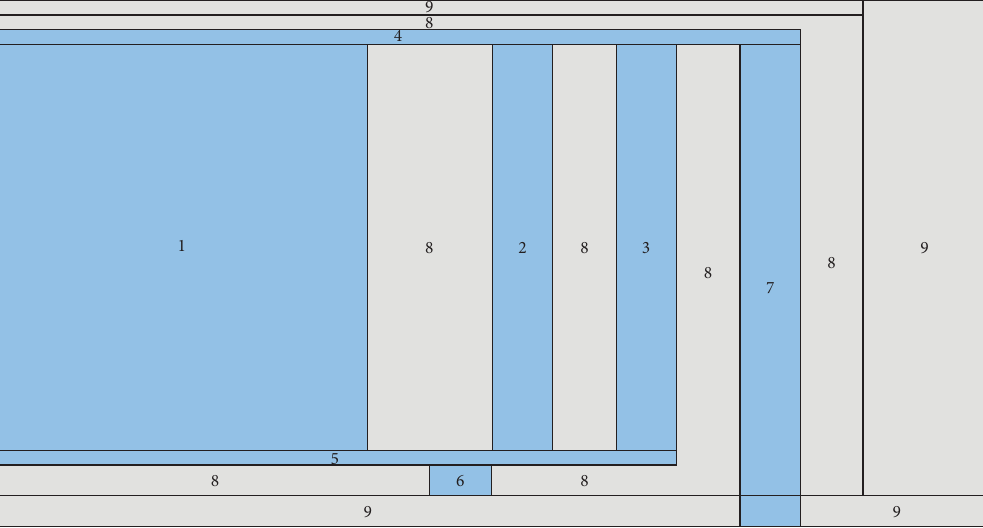
Figure 4: Simplified computation model for the HTR-PM. Blue area represents the flow region, and the gray area represents the solid region. (1) Pebble-bed core; (2) control rod channel; (3) simulated leakage flow; (4) cold helium plenum; (5) hot helium plenum; (6) core outlet; (7) helium gap; (8) side reflector; (9) carbon brick.